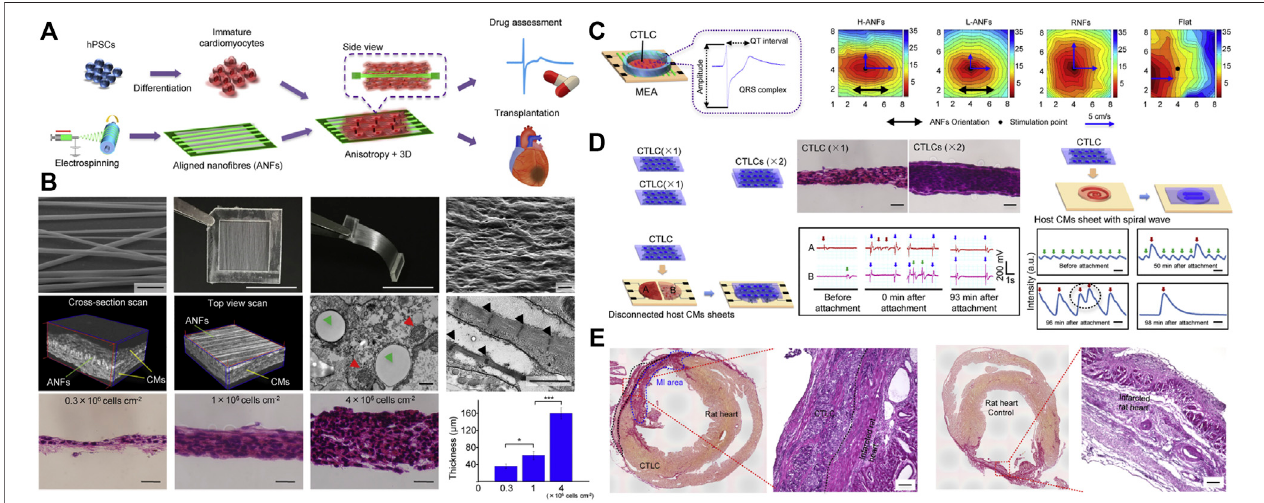
FIGURE5| The strategy ofnanomaterialsassistant stem celltherapy for MI. (A) Schematic illustration ofthepoly (lactic-co-glycolic acid) (PLGA) fabricated aligned nano fi bers (ANFs) for the high-quality cardiac tissue-like constructs (CTLCs) differentiated from human induced pluripotent stem cells (hiPSCs). (B) The construction of PLGA-mediatedANFsandtheireffectsonthe3Dcardiac tissue-likeconstructs(CTLCs). (C) SchematicrepresentationofCTLCsonthemicroelectrodearray(MEA)and a representative electrogram of the fi eld potential (FP). Activation maps showing the propagation of stimulated contractility on day 6. (D) CTLCs synchronize disconnected cardiomyocyte tissues and suppress re-entrant arrhythmia within scarred cardiomyocyte sheets. (E) Histological sections of CTLCs on the MI tissues cultured by aligned nano fi bers and acellular nano fi bers, respectively. Adapted with permission from Li et al.,